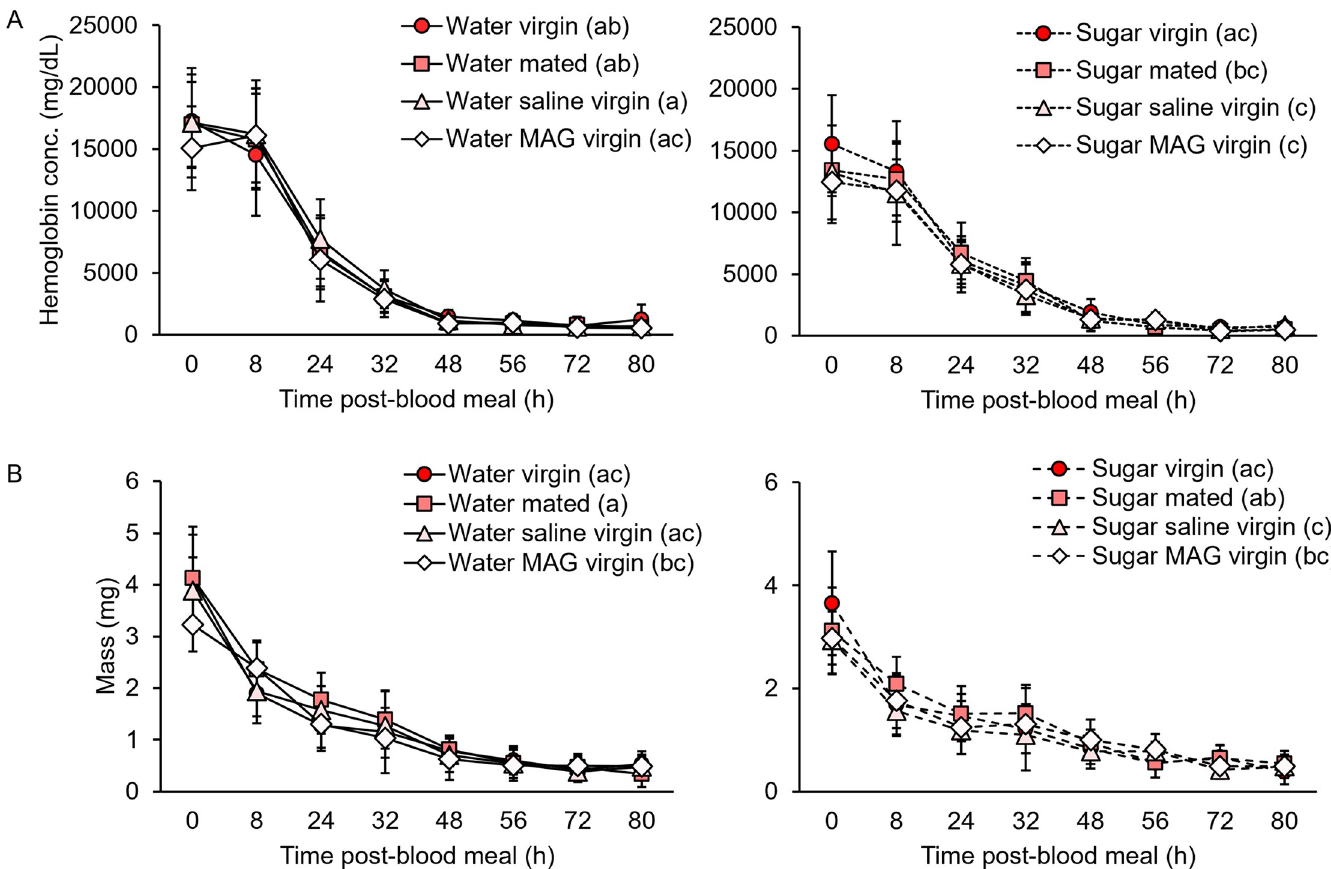
Fig 2. Mating and MAG injection do not alter blood meal digestion in an initial feeding, but sugar feeding slows hemoglobin digestion. (A) Neither mating nor MAG injection affected females’ blood digestion rates as measured by change in total hemoglobin levels over time (n = 96 total females per group). Sugar feeding led to lower starting amounts of hemoglobin and slower digestion rates compared to water-fed groups. (B) Neither mating nor MAG injection affected female blood digestion rates as measured by change in weight over time (n = 96 total females per group). Sugar feeding led to smaller blood meals but did not affect digestion rates over time as determined by this method. Error bars denote SD. Letters in parentheses next to the treatment group names denote H-B-corrected post-hoc comparison p-values.